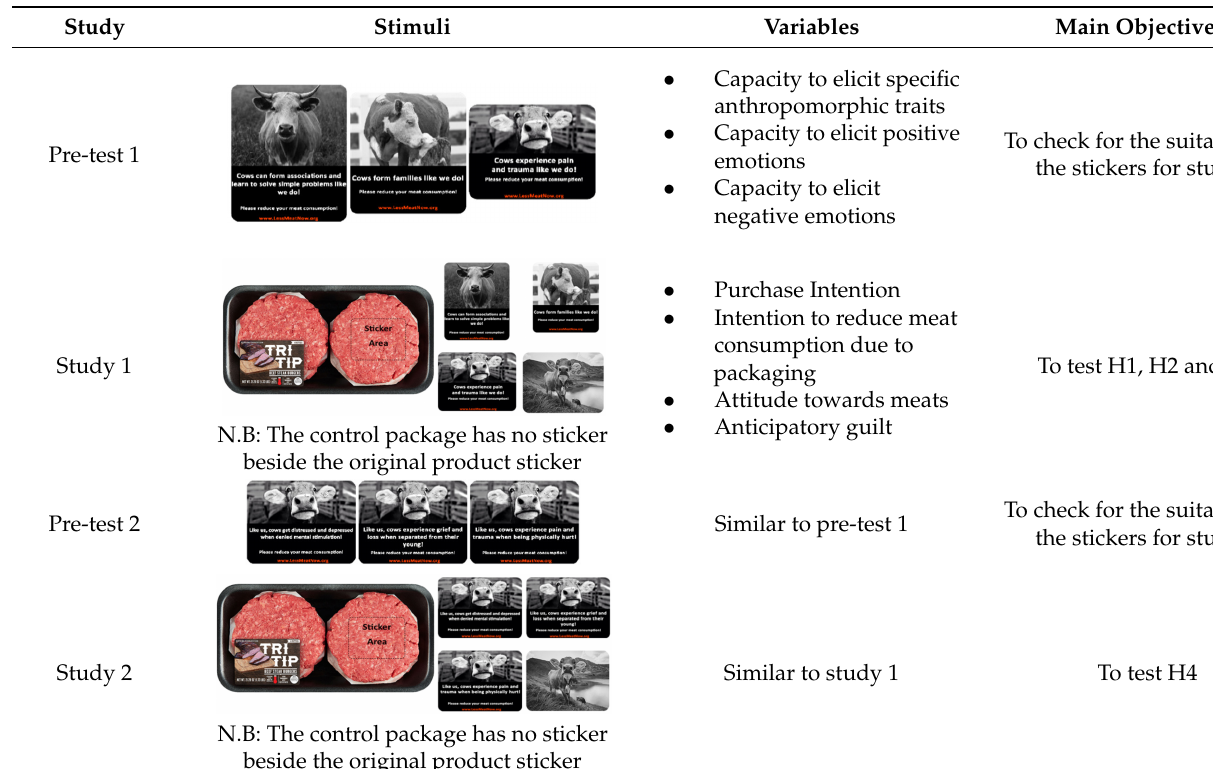
Table 1. All studies with their respective stimuli, variables and objectives.